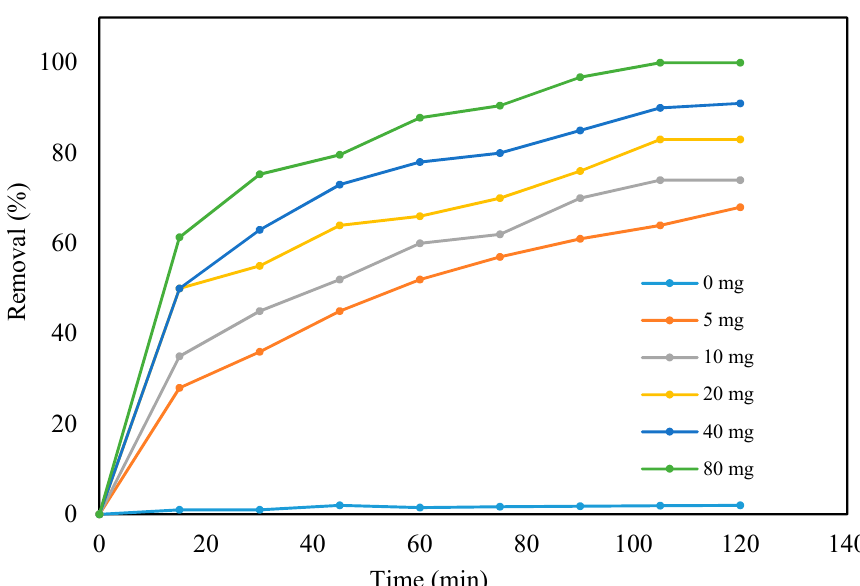
Figure 7. The effect of catalyst loading on the photoreduction of TC using Cu 7 S 4 (250 °C) as a pho- tocatalyst.